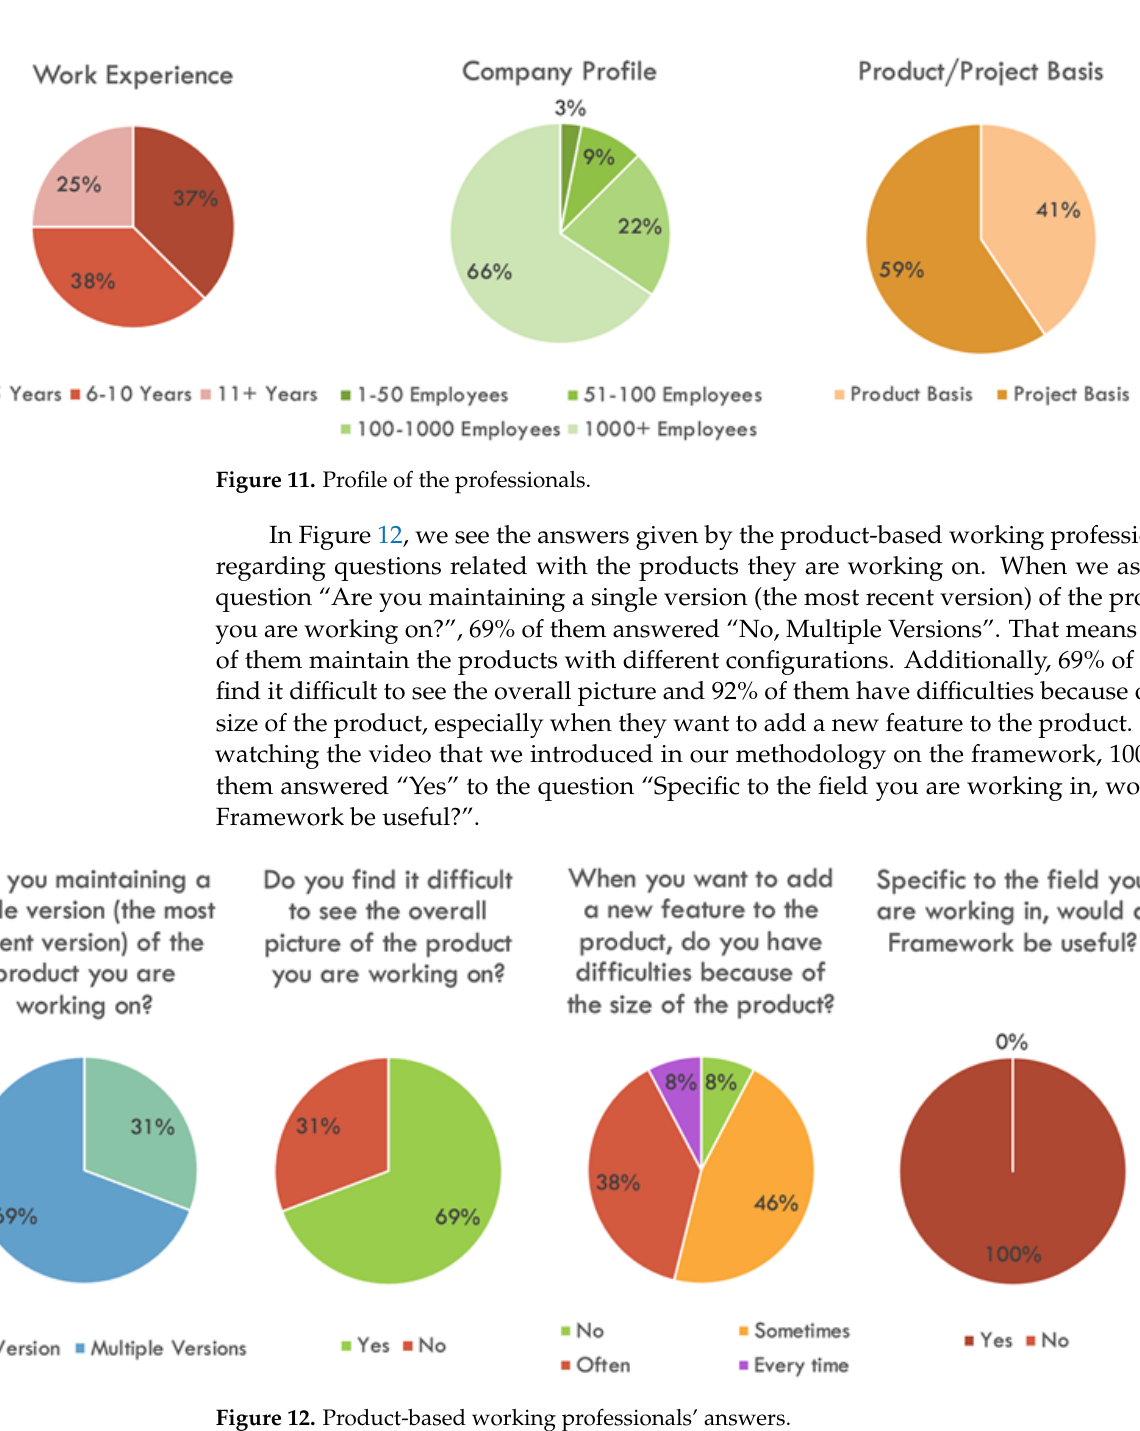
Figure 12. Product-based working professionals’